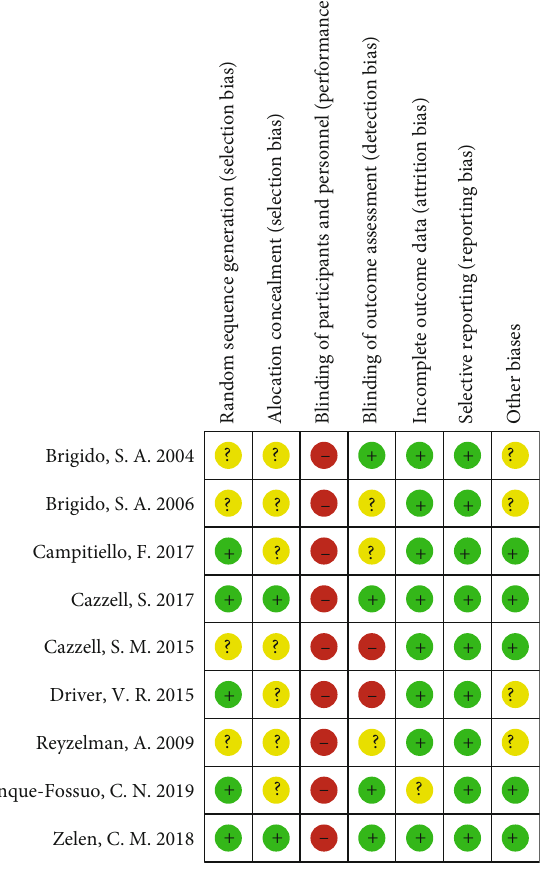
Figure 2: Risk of bias